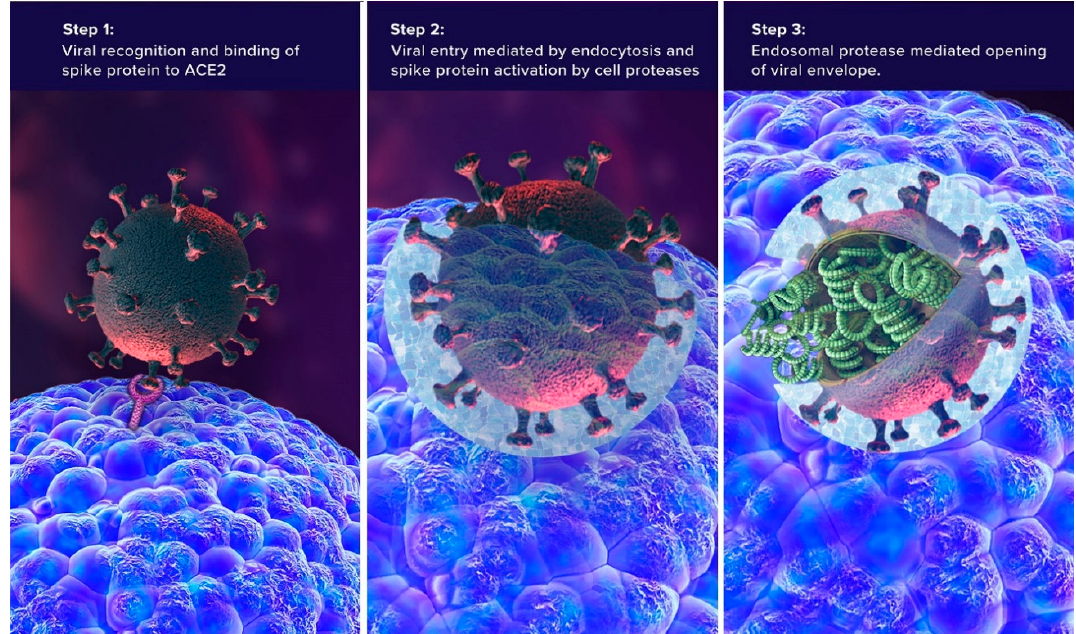
Figure 1. Interaction between ACE2 receptor and the SARS-CoV-2 virus (Contributed by Malavika Deodhar. Designed by Ernesto Lucio.)